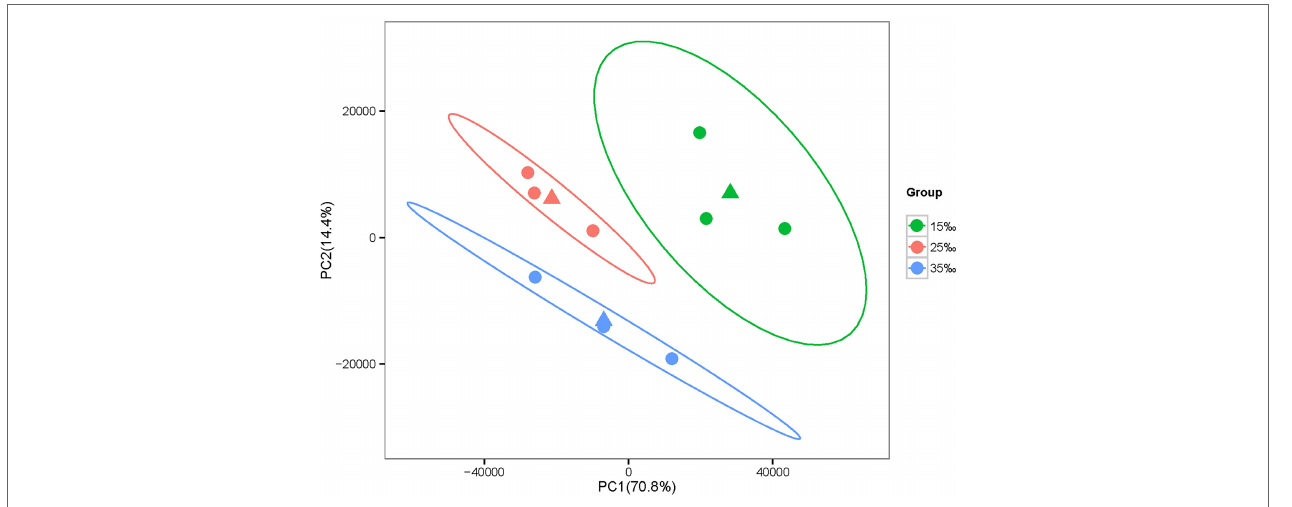
FIGURE 1 | PCA based on the expression levels of all genes. Note: The same color represents three individuals at the same salinity. Meanwhile, the difference between the first principal component (PC1) and the second principal component (PC2) can explain 70.8% and 14.4% of the all analysis results, respectively.